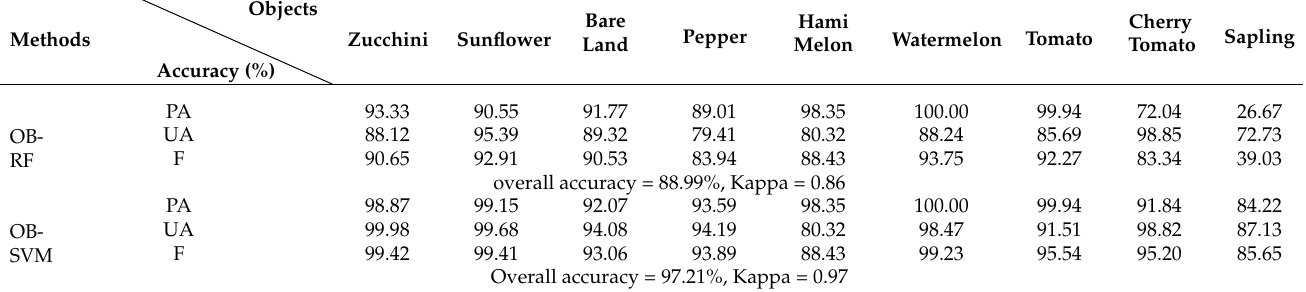
Table 9. Accuracy evaluation of classification results for